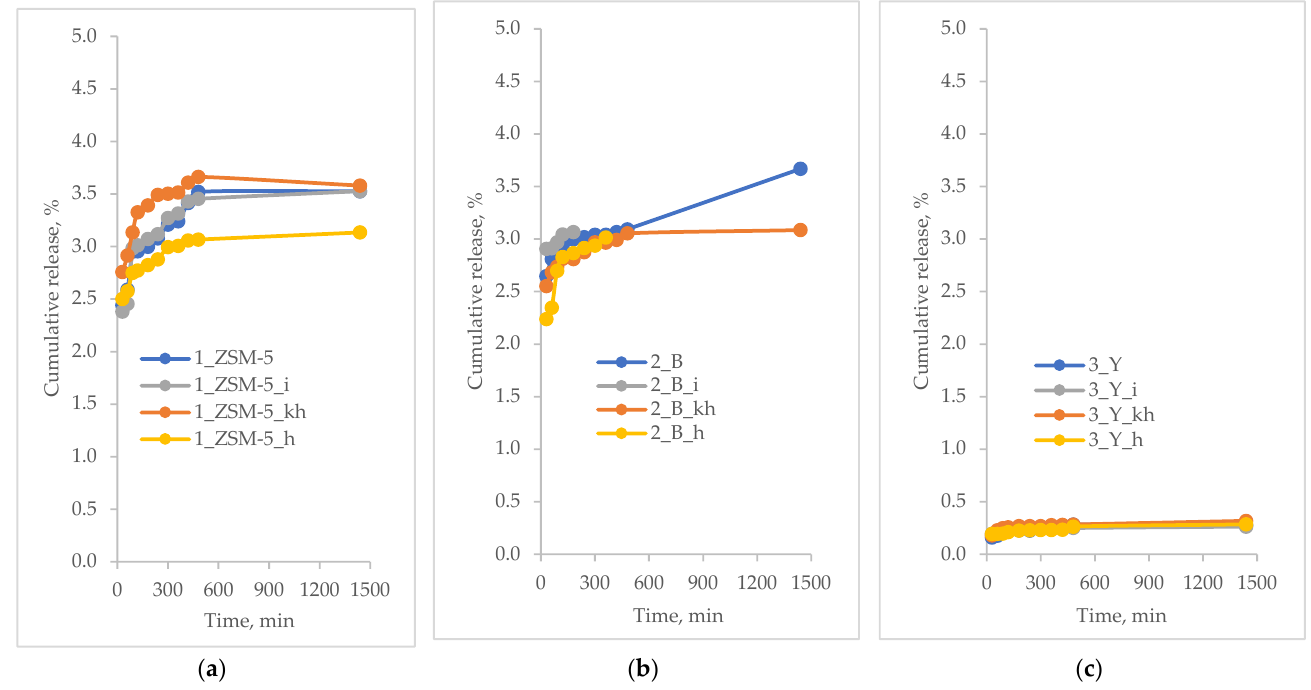
Figure 5. Percentage of curcumin released from modified hierarchical zeolites; ( a ) samples based on ZSM-5 zeolite; ( b ) samples based on BEA zeolite; ( c ) samples based on FAU zeolite.